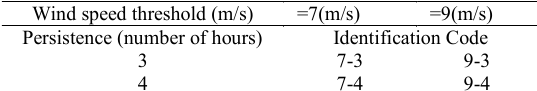
Table 1: Meteorological criteria for WD classification selected from Fedele et al., 2014 Wind speed threshold (m/s) =7(m/s) =9(m/s) Persistence (number of